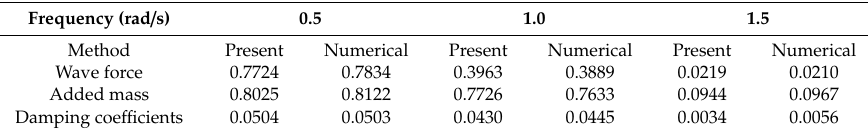
Table 1. Verification of the solution